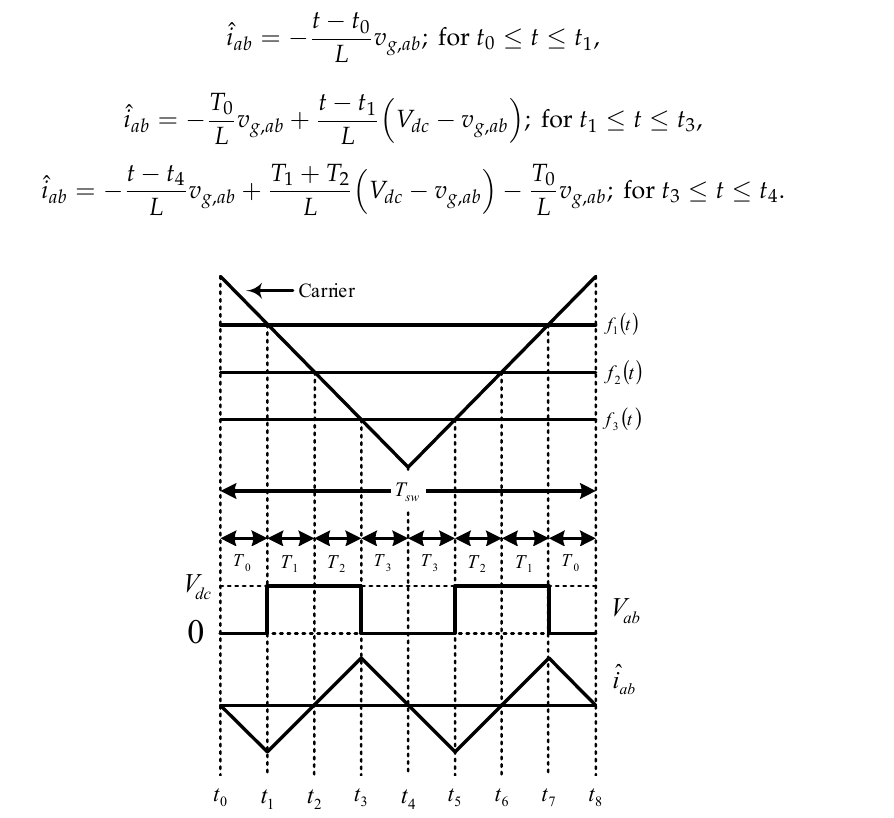
Figure 10. Load current ripple and output line-line voltage during a switching period.